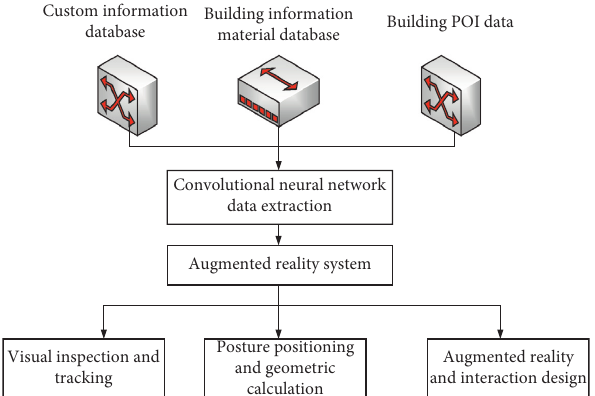
Figure 1: Building data visualization